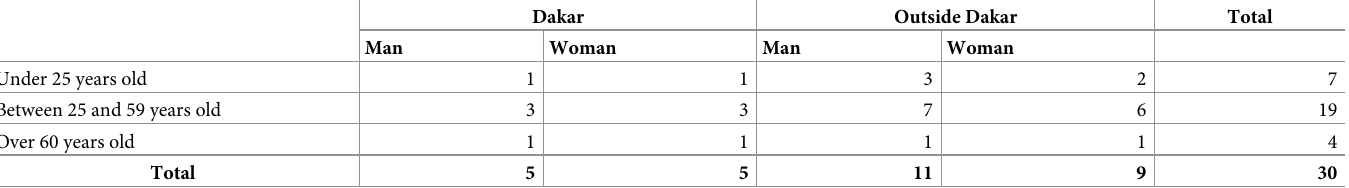
Table 2. Characteristics of the qualitative sample (n =